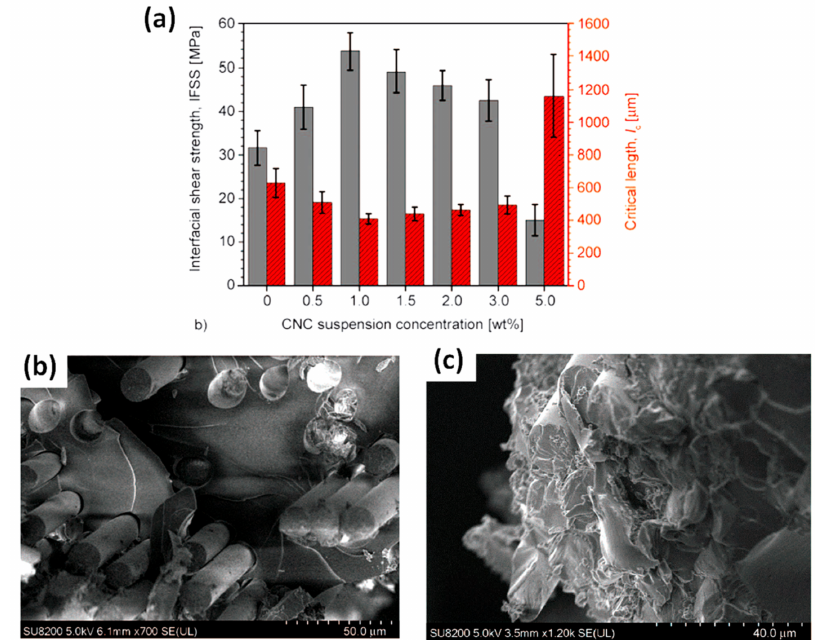
Figure 16. ( a ) SFFT results with the IFSS (solid grey bars) and critical fragmentation length (striped red bars) for short glass fibres/epoxy composites as a function of CNC concentration in suspension, failure surfaces observed for ( b ) 30 wt% uncoated glass fibre and ( c ) 30 wt% CNC-coated glass fibre (1 wt% CNC in suspension) reinforced epoxy composites (reprinted with permission from Asadi et al. (2016)